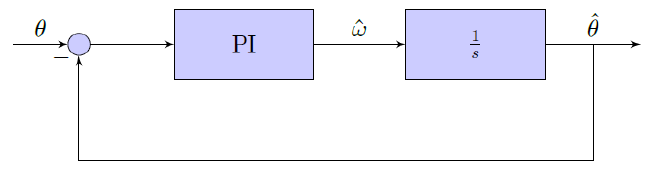
Figure 4. Control loop to filter out position sensor’s